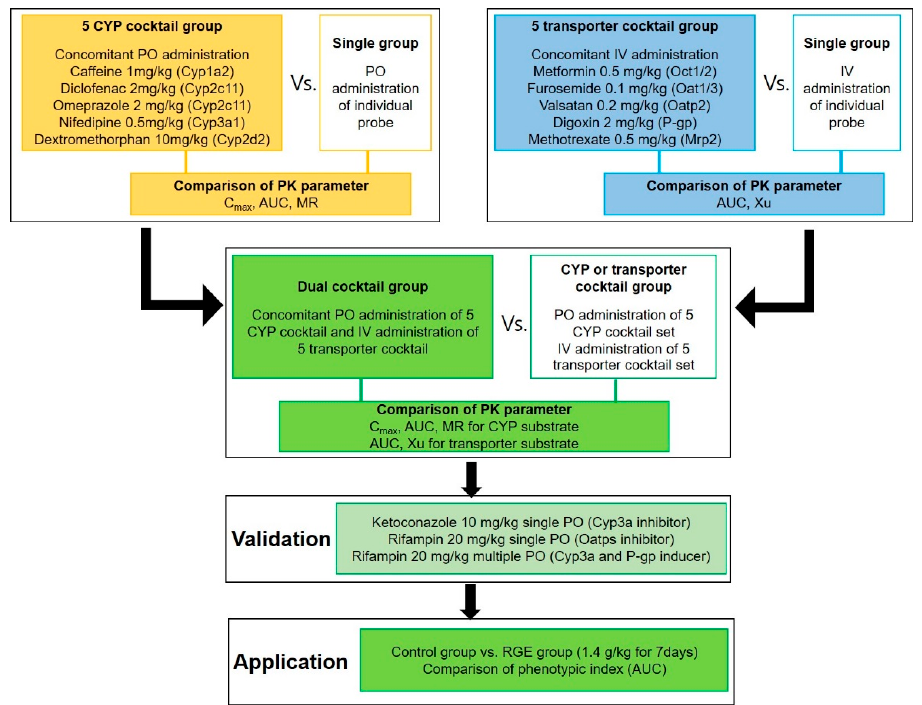
Figure 1. Strategy for the “Dual Cocktail” development. CYP; cytochrome P450, PO; per oral, IV; intravenous, PK, Pharmacokinetics, C max ; maximum plasma concentration, AUC; area under plasma concentration curve, MR; metabolic ratio calculated by dividing metabolite AUC by parent AUC, Xu; excreted amount of substrate via renal route, RGE; red ginseng